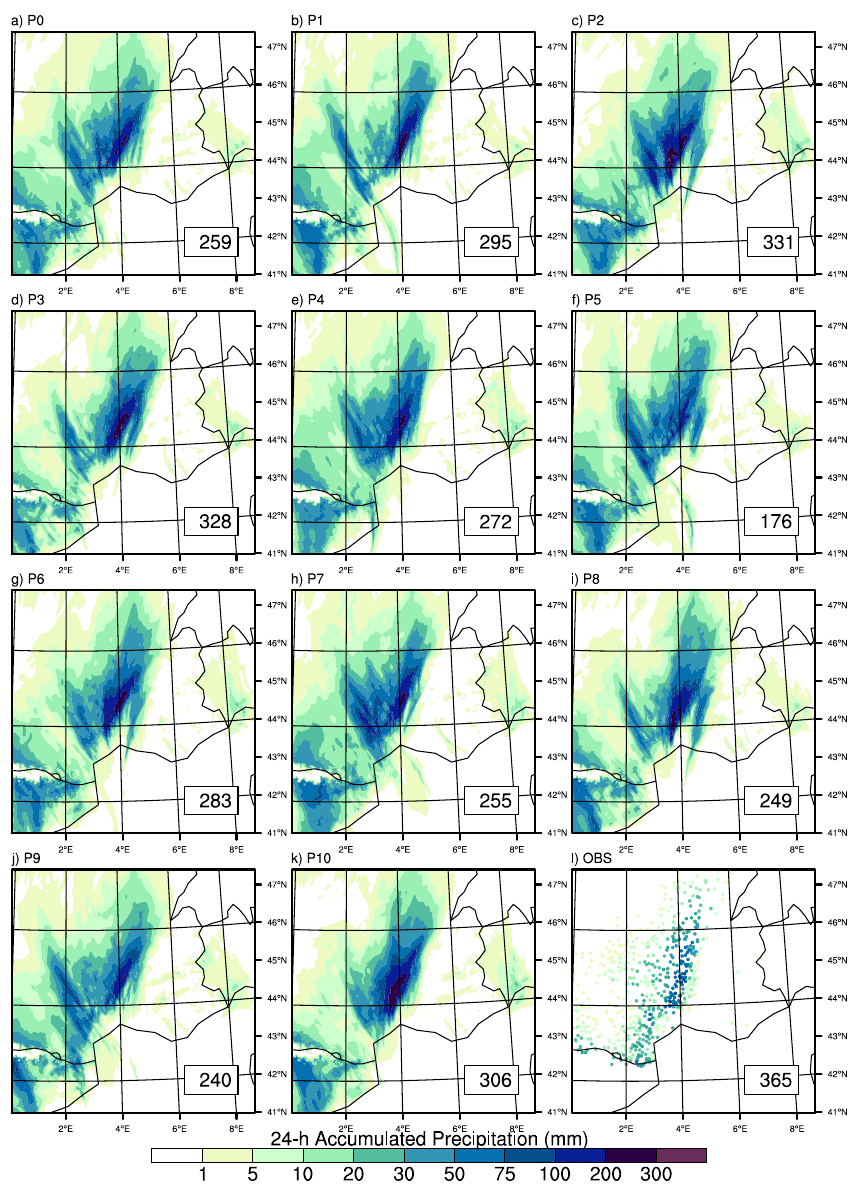
Fig. 7. Accumulated precipitation (mm) between 12:00 UTC 1 November and 12:00 UTC 2 November 2008 from (a-k) AROME simulations and (i) rain gauges (over France only). The figure in the white box gives the maximum of precipitation.